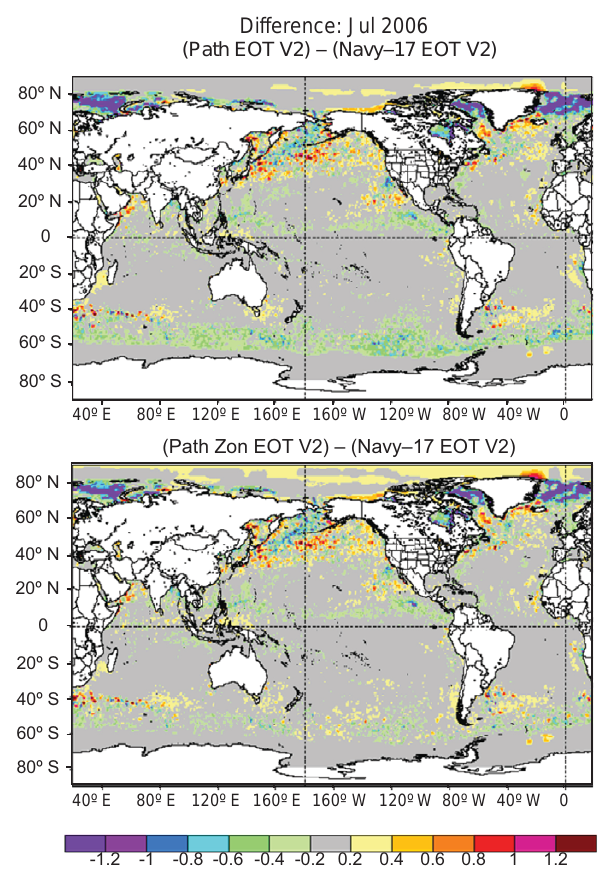
Figure A3. Average July 2006 difference between the daily AVHRR-only OI using Pathfinder NOAA-17 data and operational Navy NOAA-17 data. All versions use bias-corrected satellite data. In the top panel the Pathfinder daily OI uses no preliminary zonal bias correction; in the bottom panel the Pathfinder daily OI uses a preliminary zonal bias